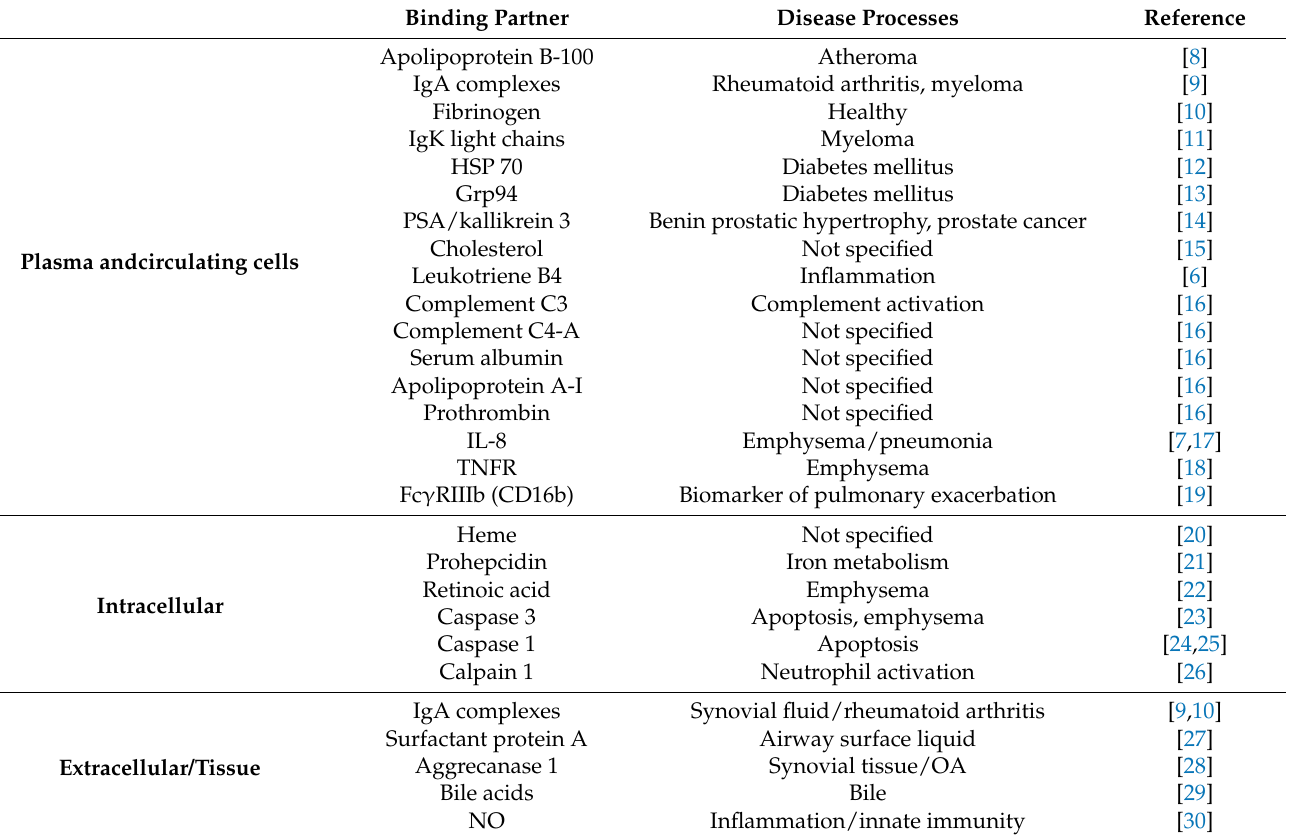
Table 1. Known binding partners to alpha-1 antitrypsin in health and